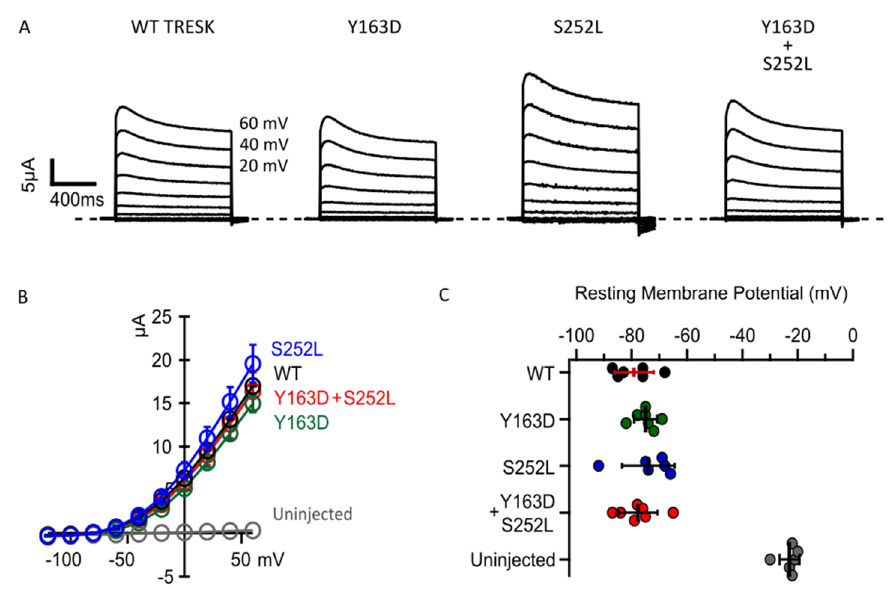
Figure 2. p.Tyr163Asp and p.Ser252Leu do not significantly affect the basal current and ability of TRESK channels to control the cell’s resting potential. ( A ). Representative families of current traces for the indicated channel types. Cell membrane potential was held at − 80mV. Each family of currents was evoked by voltage steps from − 120 mV to 60 mV, with 20 mV increments. The recordings were performed 48 h after the injection of 1 ng of mRNA for each channel type. ( B ). Average IV relationships calculated from experiments as in A for the labelled channel types (color coded). The data points are mean ± standard error (*** p < 0.001; n = 12). ( C ). Resting membrane potentials from individual oocytes un-injected (grey dots), injected with 1 ng of WT (black dots) or Y163D (green dots) or S252L (blue dots) or 0.5 ng of each Y163D and S252L (red dots) mRNA and recorded 48 h after injection. Note that the expression of all channel types similarly shifts the resting potential toward K + reversal potential. The dots in C represent single cell recordings. The data are mean ± standard